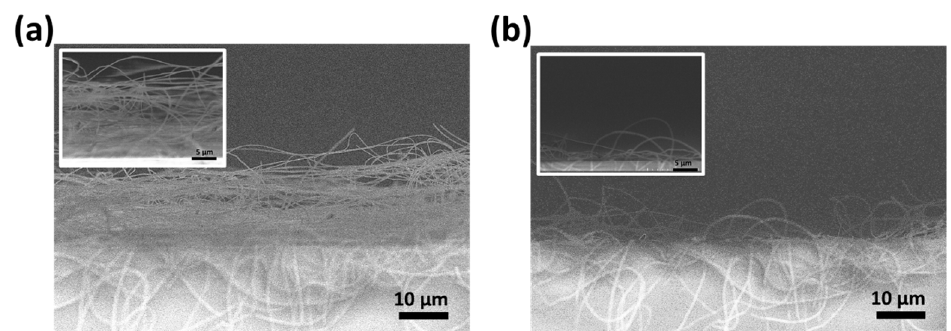
Figure 6. The cross − sectional FESEM images of WO 3 /SnO 2 /Ag/PMMA sensing materials ( a ) before and ( b ) after being exposed to acetone.